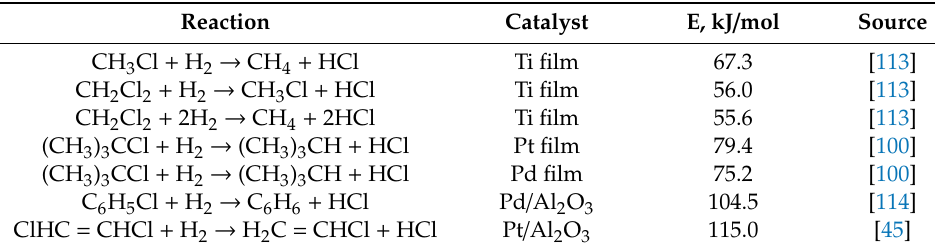
Table 5. Activation energy for